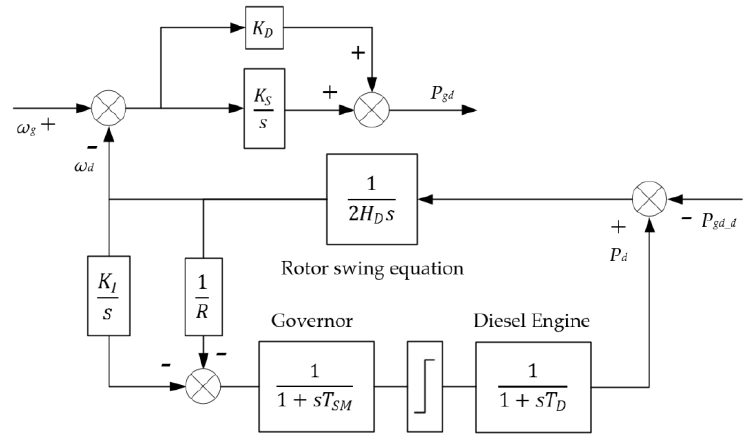
Figure 9. Block diagram of the diesel generator model [131].